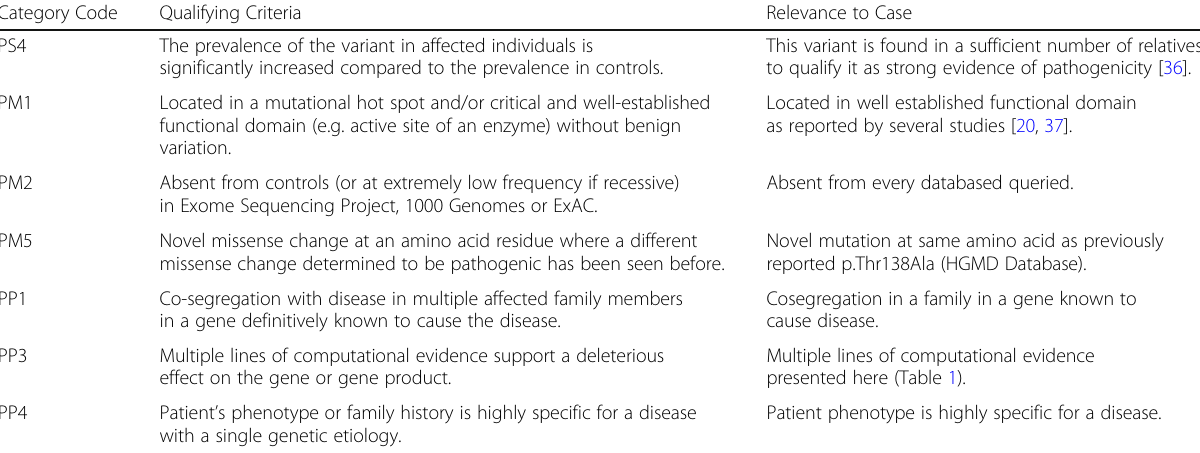
Table 4 The ACMG guidelines applicable to the novel variant in question, p.